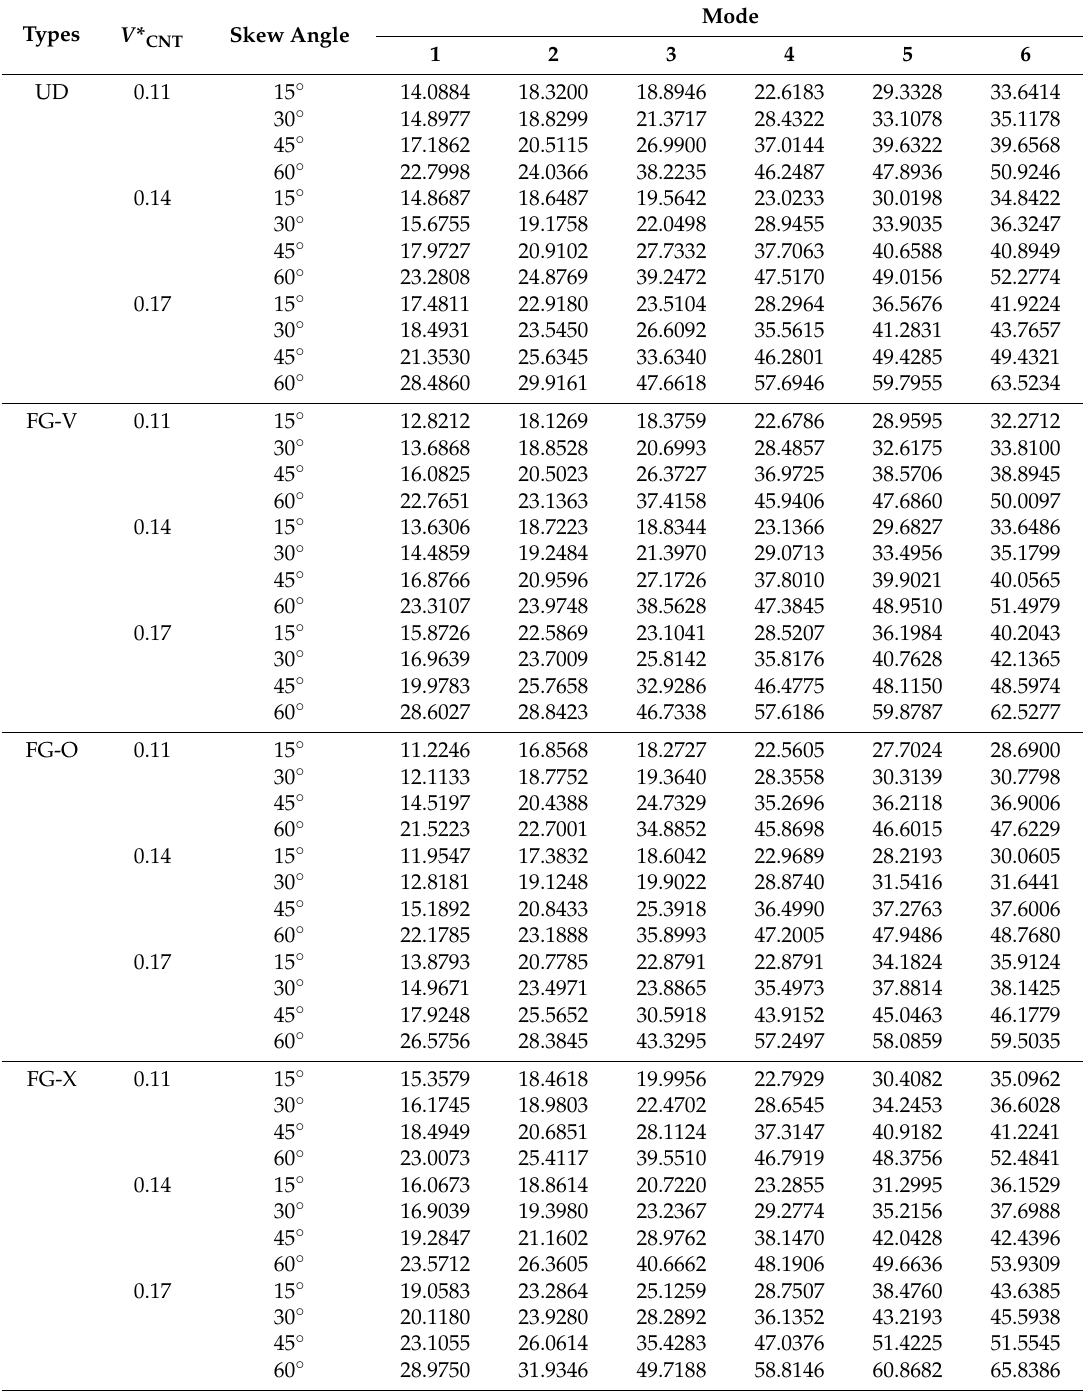
Table 10. Variation of first six natural non-dimensional frequency parameters of simply supported FG-CNT-reinforced rhombic